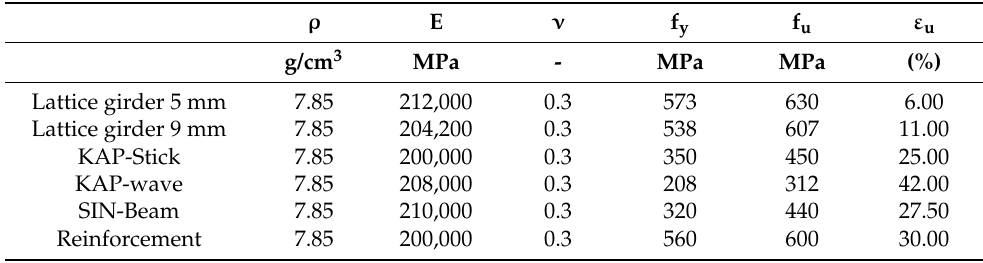
Table 4. Material parameters (nominal stresses) for steel (reinforcement used for cross-frames and push-off